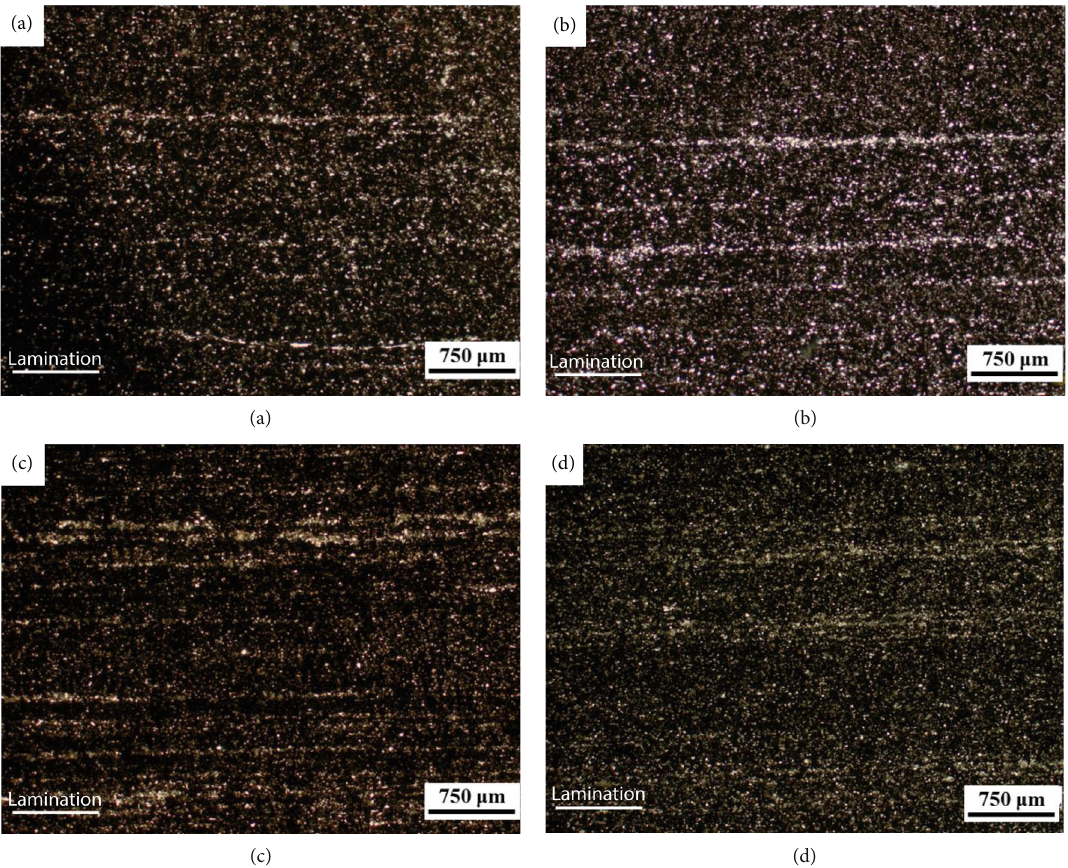
Figure 5: Transmitted light thin section images of argillaceous/siliceous mixed shale lithofacies (M). (a) Laminae of silty quartz. JYA-6, = 25 : 9 μ D , permeability anisotropy ð β Þ = 2 : 9 , 2549.19m. (b) Laminae of silty quartz. JYA-10, K K h = 8 : 9 , 2563.4m. (c) Well-laminated fabric. Mixed organic matter and clays distributed between the laminae. JYA-11, K 2569.28m. (d) Slight laminae of silty quartz. JYA-16, K h = 11 : 3 μ D ,